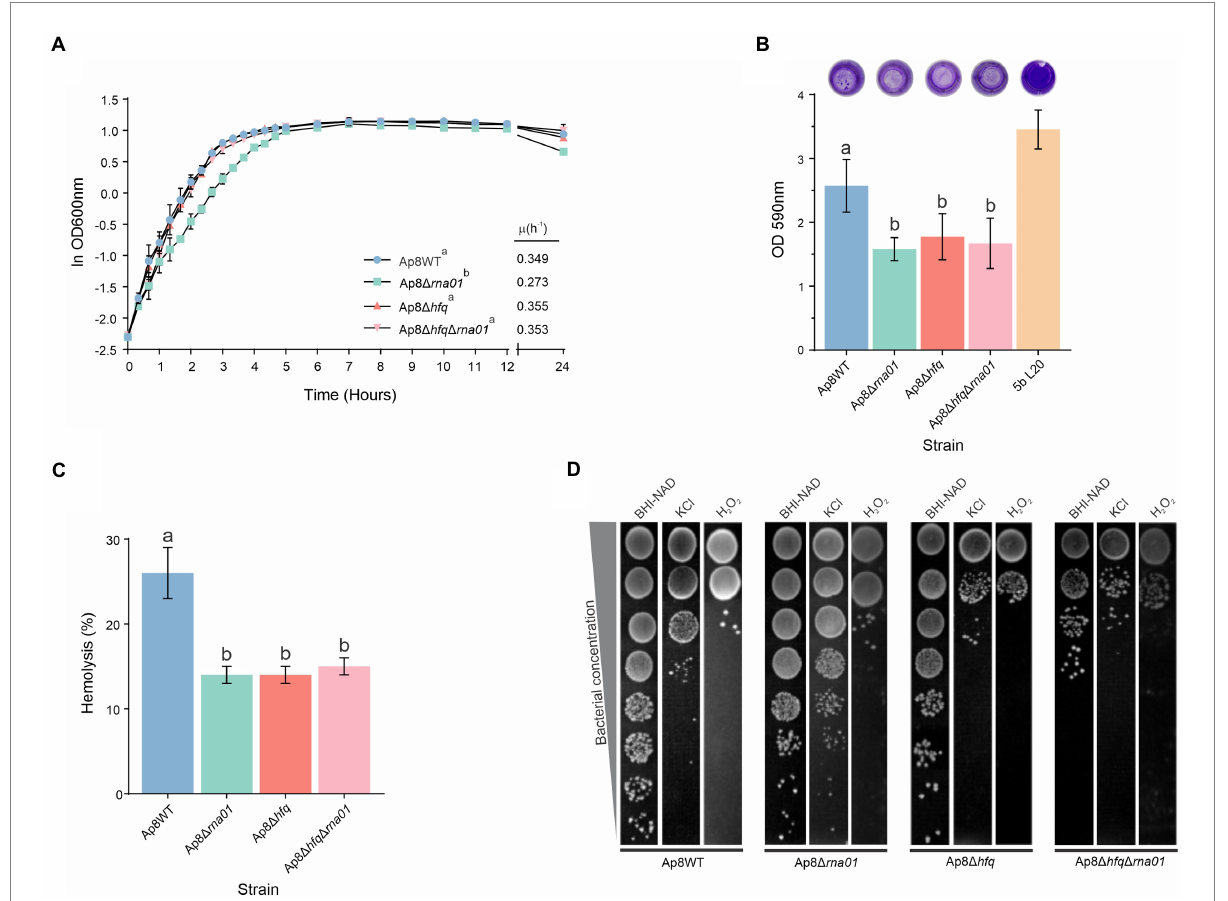
FIGURE 6 Phenotypic characterization of Actinobacillus pleuropneumoniae rna01 mutant strains. (A) Bacterial growth in BHI-NAD at 37 ° C. Maximum growth rates ( μ ) are shown in the bottom-right corner. (B) Biofilm formation in polystyrene microtiter plates. The reference strain 5b L20 was used as positive control for biofilm formation. (C) Hemolytic activity on sheep blood agar. (D) Stress tolerance in KCl (0.1 M) and H 2 O 2 (0.2 mM). Means with different letters are significantly different by the Tuckey’s test. The experiment was performed in